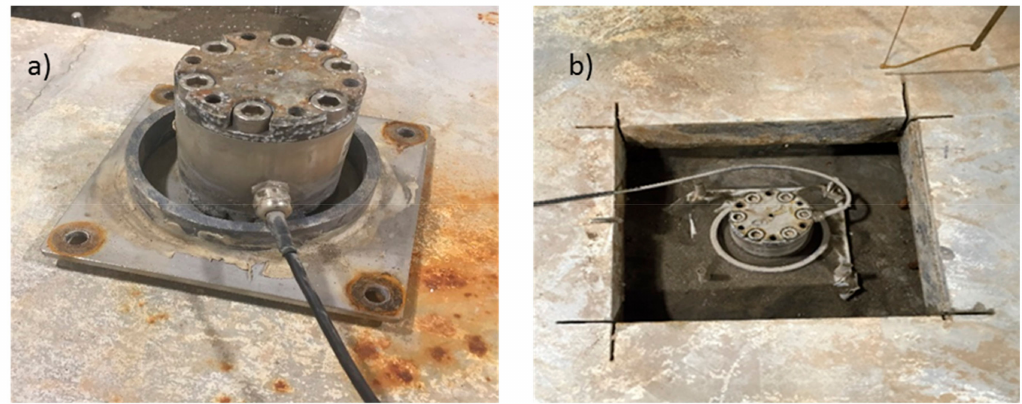
Figure 3. ( a ) Dynamometer (Interface-6A68E) and ( b ) dynamometer embedded in the flume